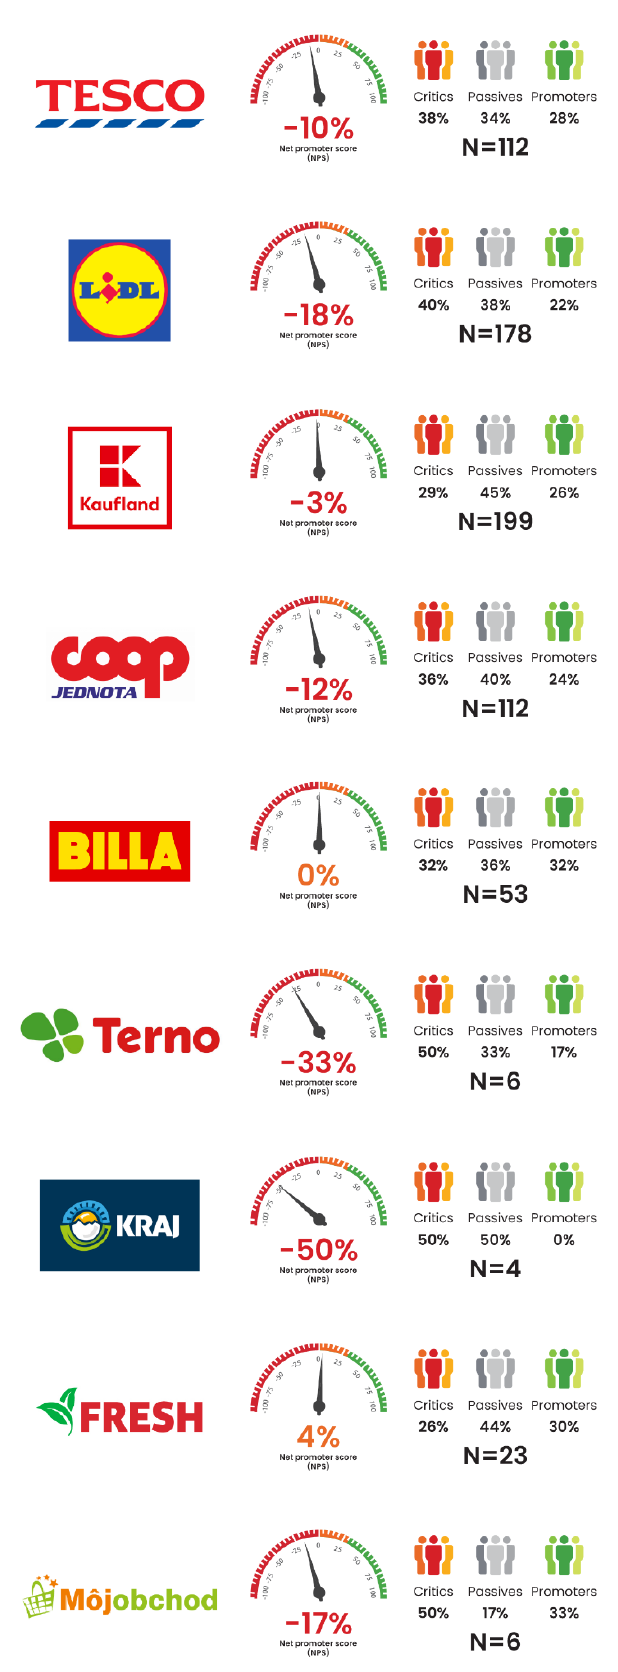
Figure 5. Score of the shopping atmosphere in grocery shops.